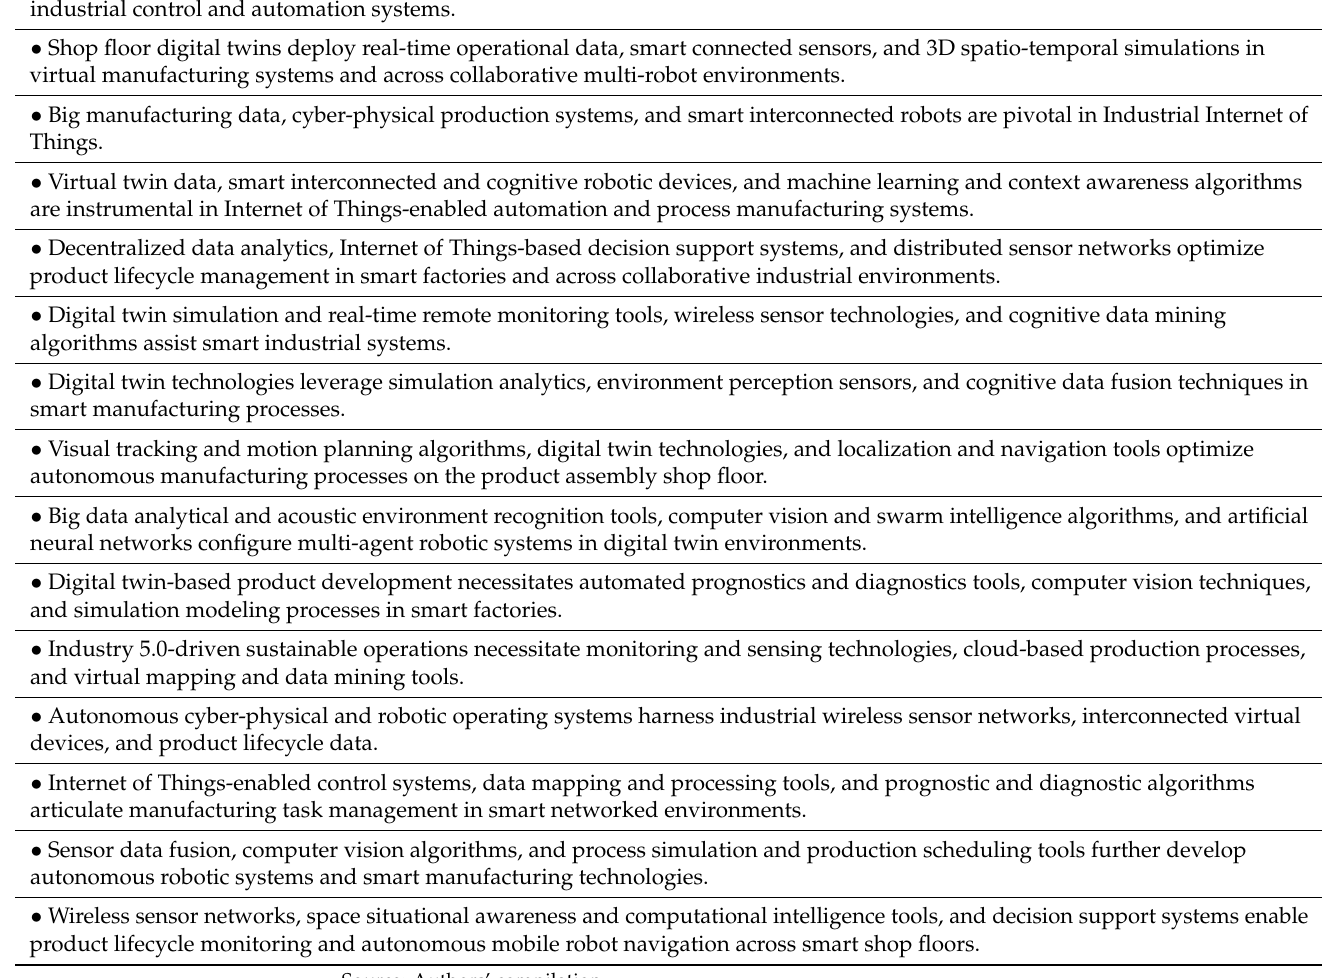
Table 2. Comparison chart covering performance measurement data